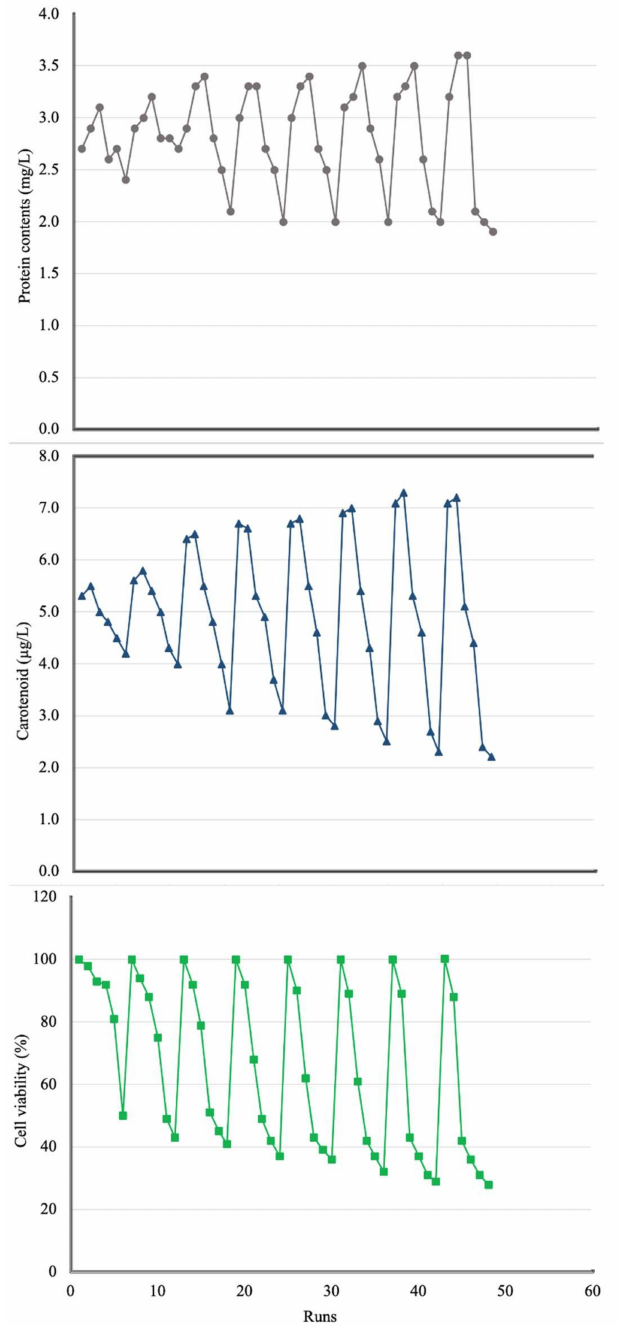
Figure 4. Toxicological effects of antibiotics on marine